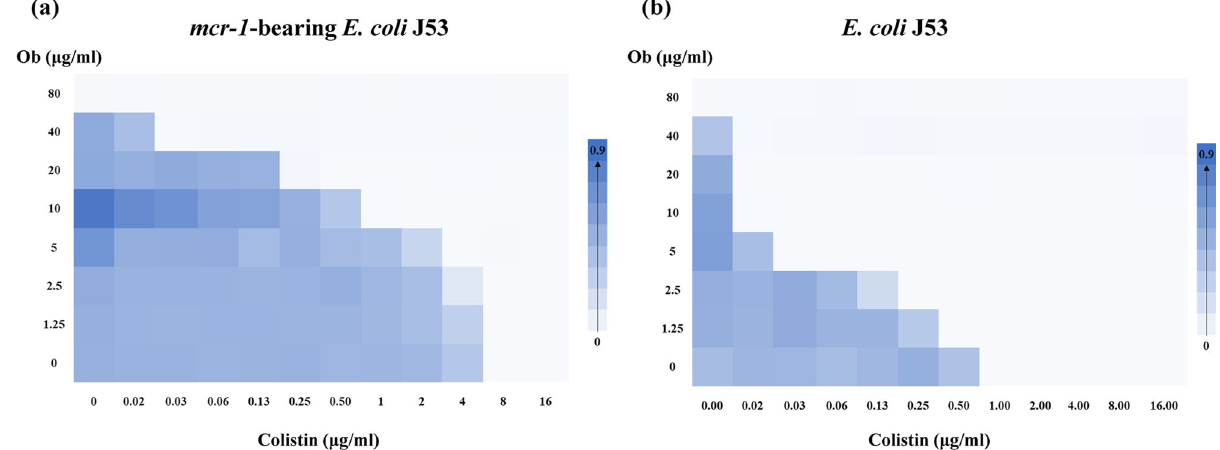
Fig. 1 Checkerboard analysis of the synergistic antimicrobial effect of colistin and Ob on both colistin-resistant and colistin-susceptible E. coli . a Colistin-susceptible E. coli J53. b Colistin-resistant E. coli J53 carrying a mcr-1 -bearing plasmid which was originally recovered from a clinical E. coli strain. CT,